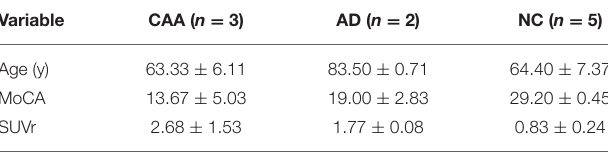
TABLE 3 | Description of variables from the three groups comparison.